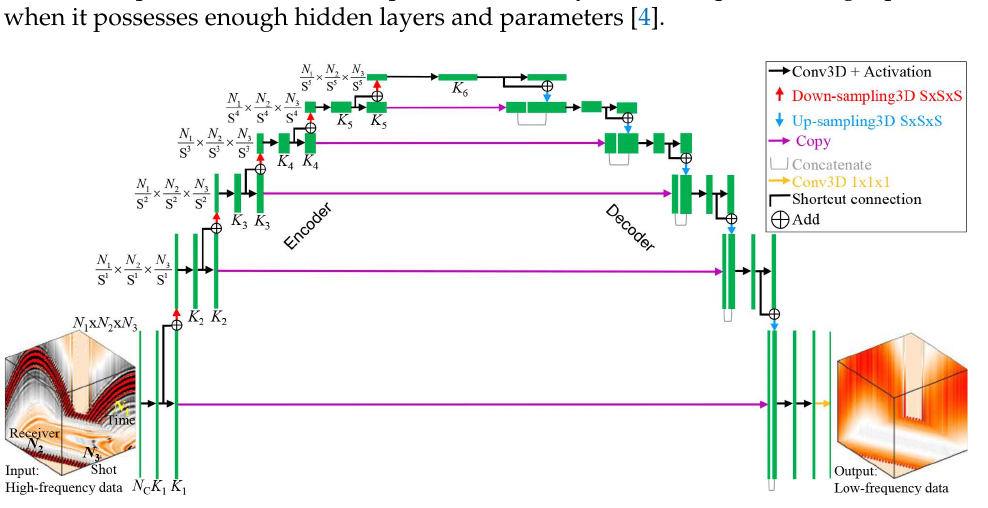
Figure 4. Illustration of the employed 3D CNN architecture, where N 1 , N 2 , and N 3 denote the sizes of the time, receiver, and shot axes of the input HF seismic data X ( (cid:62) 5 Hz), respectively, S is the pooling size by which N 1 , N 2 , and N 3 are downscaled, N C is the number of channels of the input X , and N C = 1. Each green box represents feature maps, and the number of convolutional kernels ( K i , i ∈ [ 1, 6 ] ) is marked. The CNN’s output (lower right) is the LF target Y (<5 Hz). CNN’s parameters are optimized for regressing low frequencies from high